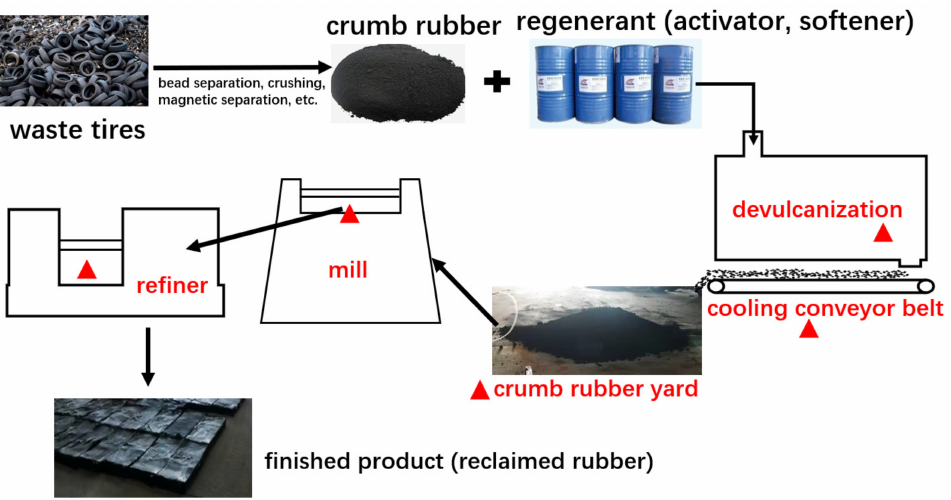
Figure 1. Typical process flowchart of waste rubber tire